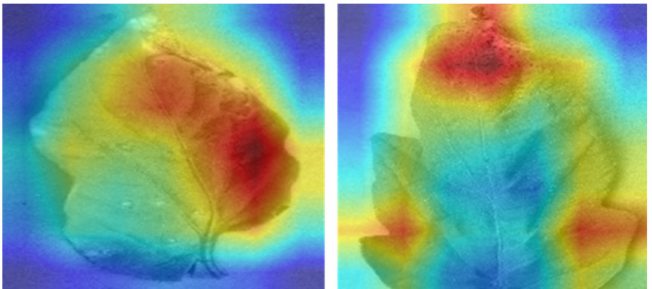
Figure 2. Score-CAM visualization of tomato leaf images, to show where the CNN model is mainly taking the